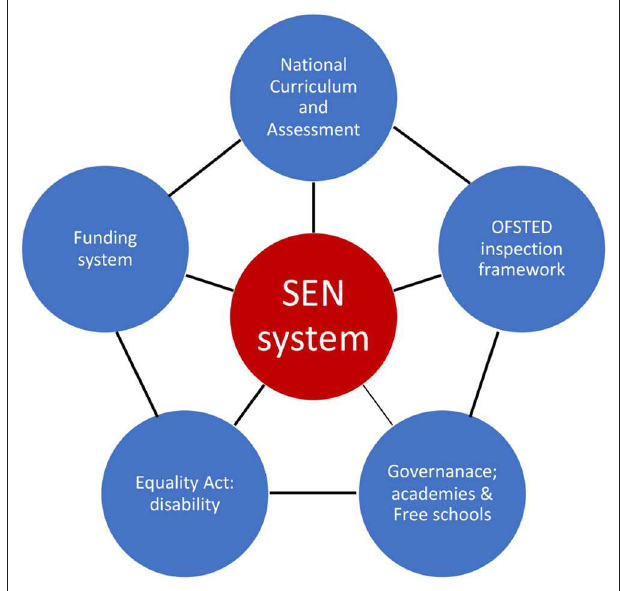
FIGURE 1 | Interdependence of the SEN system with other